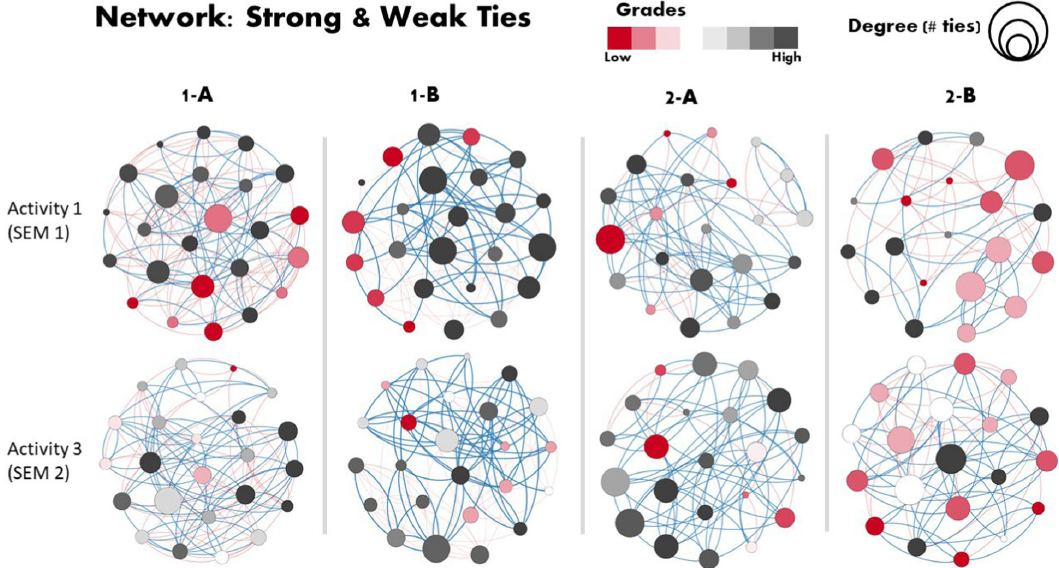
FIG. 5. Strong and weak collaboration network on activities 1 (end of semester 1) and 3 (end of semester 1) for each class. Node color represents academic performance from low (red) to high grades (black); size of nodes indicates degree centrality — number of collaborative ties; edges ’ colors indicate strong ties (blue) and weak ties (red).